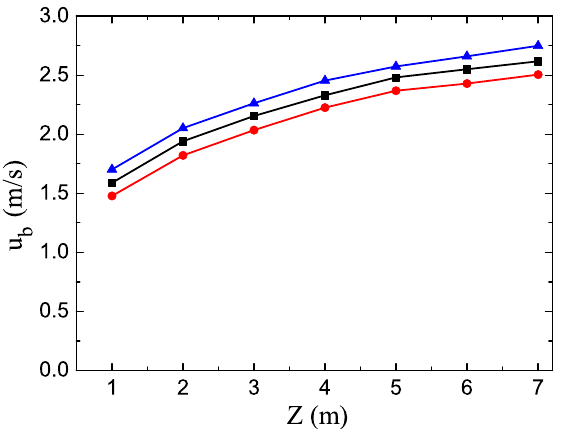
Figure 5. The speed of the bubbles versus the height Z for the different